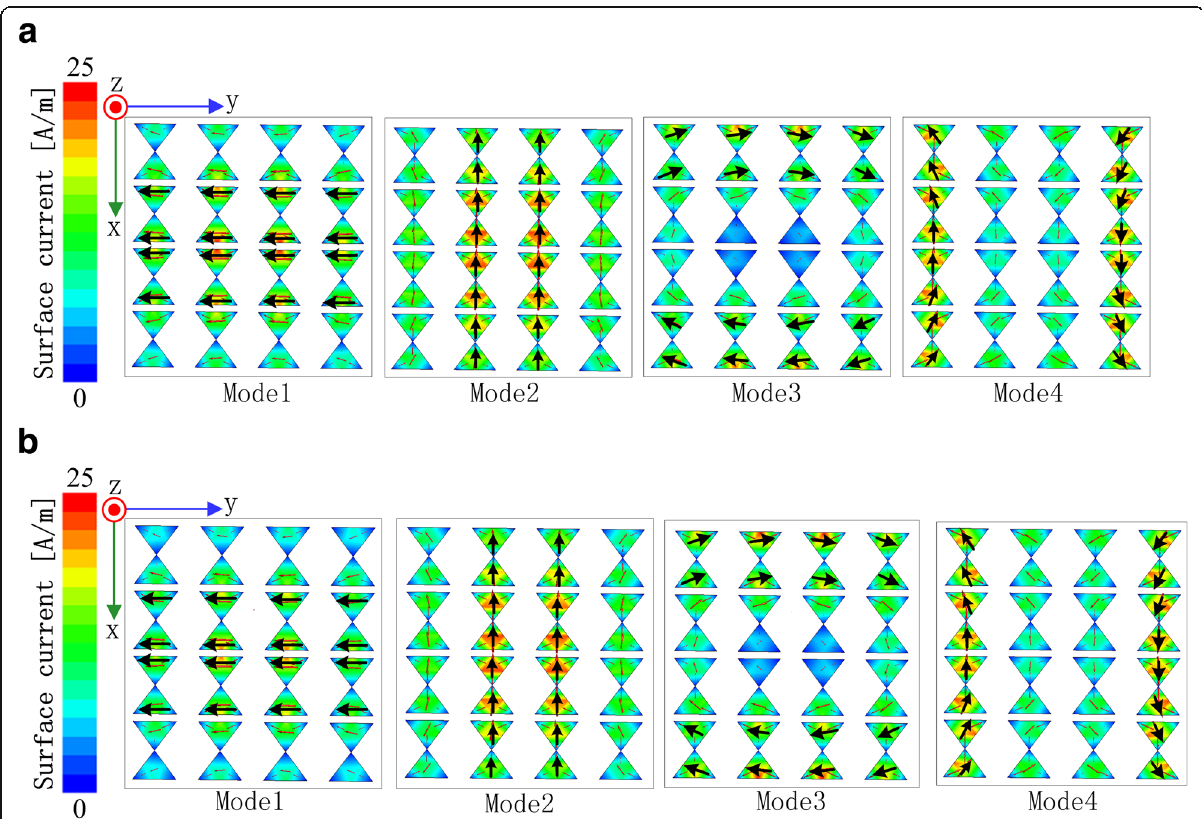
Fig. 3 Modal surface current of mode 1, mode 2, mode 3 and mode 4. a 5.35 GHz and b 5.75 GHz